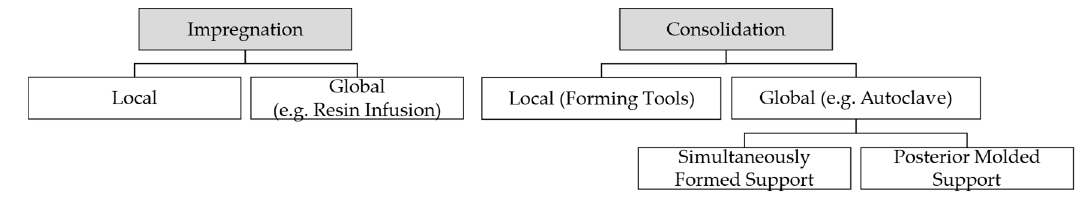
Figure 8. Possible process alternatives for impregnation and consolidation.